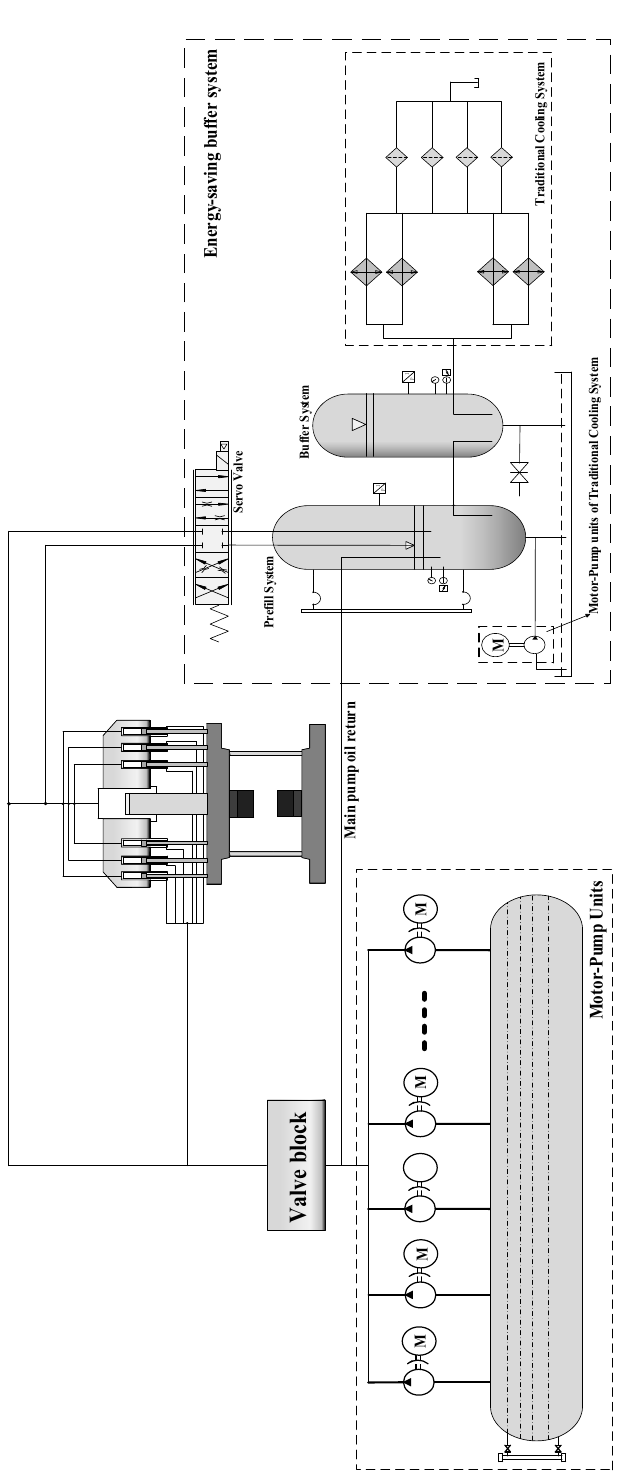
Figure 4. Diagram of the proposed energy ‐ saving buffer system.